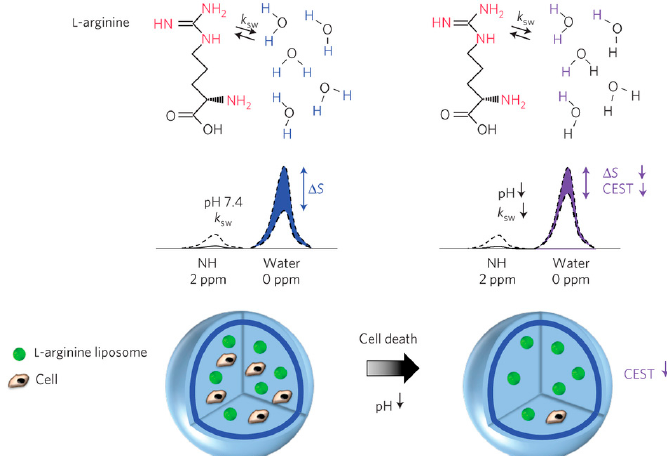
Figure 6. Schematic representing the principles of in vivo detection of cell viability using LipoCEST microcapsules as pH nanosensors. The CEST contrast is measured by the drop in the signal intensity ( Δ S ) of water after selective saturation (that is, removal of capability to generate signal) of the NH protons in L -arginine at 2 ppm. The L -arginine protons (red) inside the LipoCEST capsules exchange saturation (ksw) with the surrounding water protons. The ksw is reduced at lower pH causing a significant drop in CEST contrast. The images are reprinted with permission from Chan et al. [93].